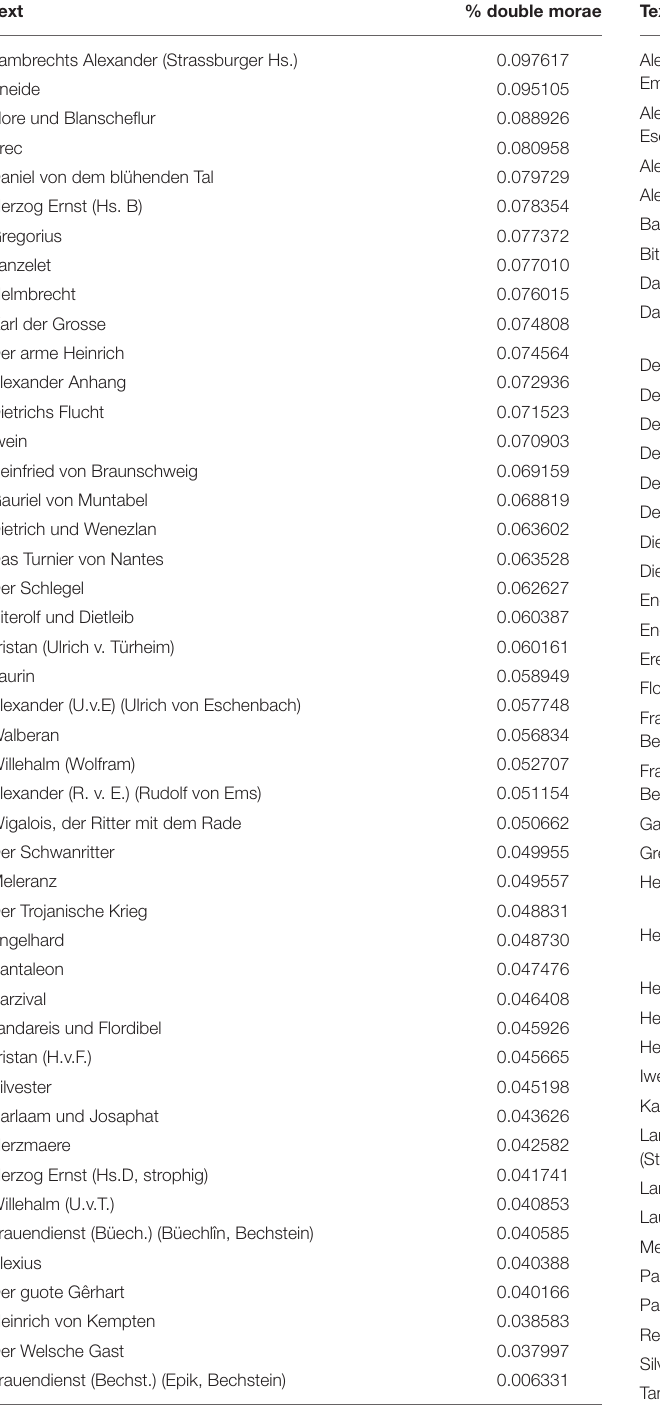
TABLE 13 | Ratio of double morae syllables. TABLE 14 | Double morae word